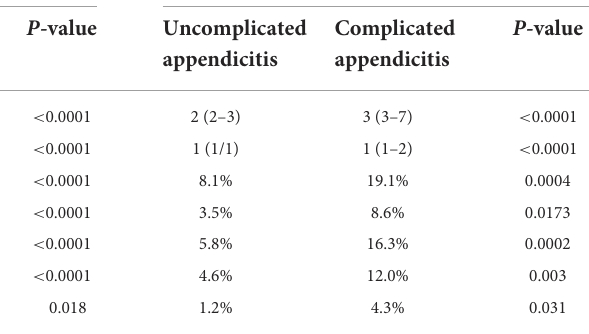
TABLE 4 Post-operative outcomes for both complicated and uncomplicated appendicitis, based on intraoperative and histopathological classifications. Post-operative